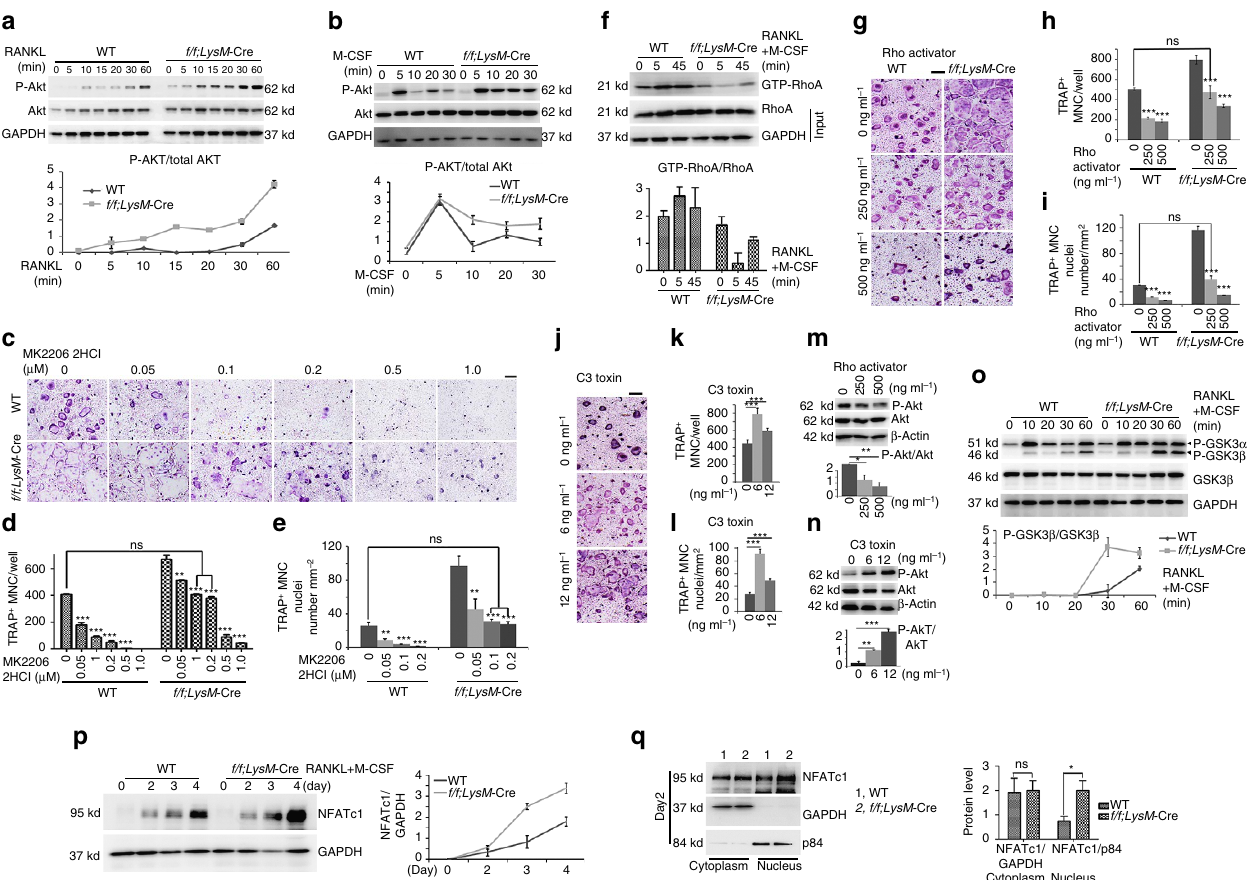
Figure 4 | Knockout of Gna13 enhances Akt-GSK3 b -Nfatc1 signalling through RhoA. ( a ) Western blot analysis to detect Akt phosphorylation induced by RANKL in WTand Gna13 f/f LysM -Cre ( f/f;LysM- Cre) monocytes/macrophages. N ¼ 3. ( b ) Western blot analysis to detect Akt phosphorylation induced by M-CSF in WT and Gna13 f/f LysM -Cre monocytes/macrophages. Lower panel in a – b , Quantification of phospho-Akt level versus total Akt level; N ¼